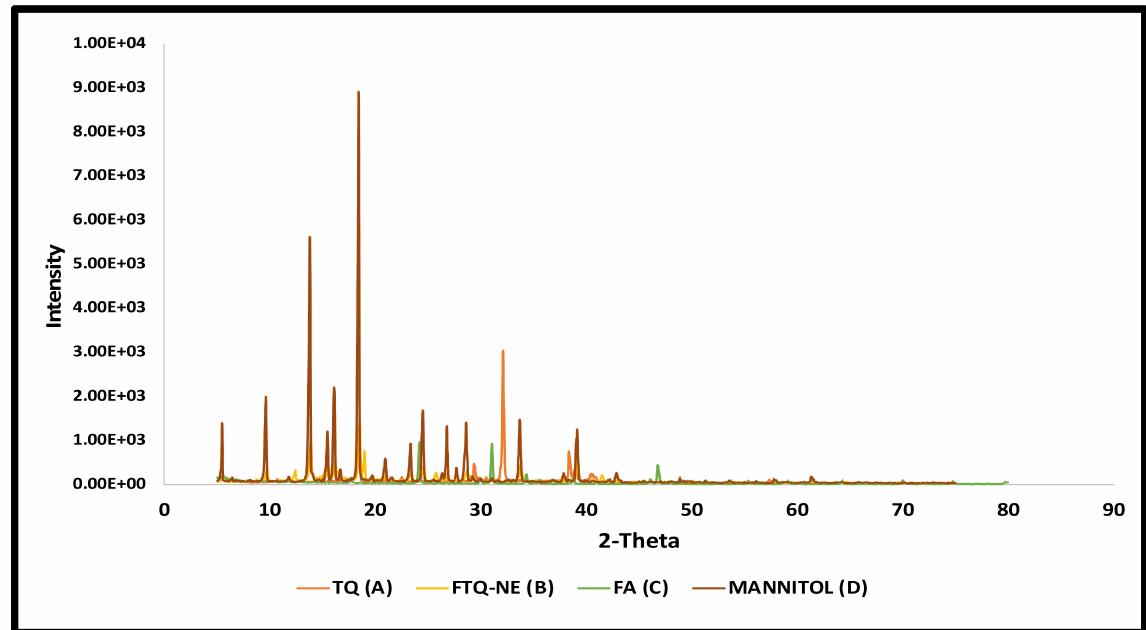
Figure 8. Overlay of X-ray